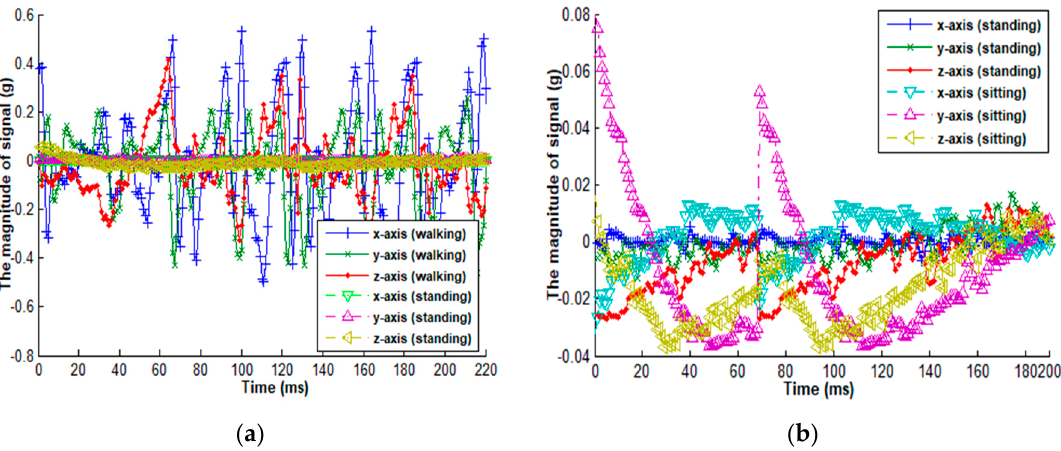
Figure 1. Comparison of the magnitude of a tri-accelerometer among three different activities. The accelerometer has sensor readings from three axes, i.e., x-axis, y-axis, and z-axis. ( a ) Comparison of walking and standing; ( b ) Comparison of standing and sitting.